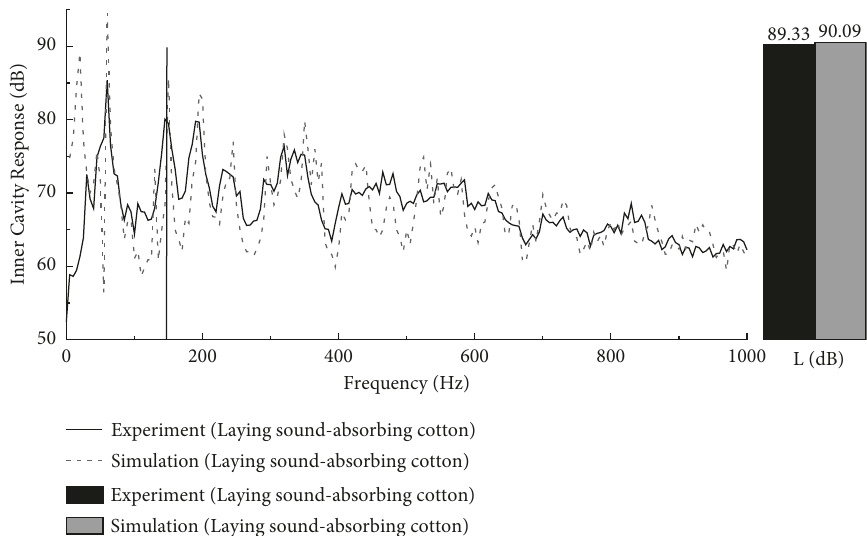
Figure 6: Comparison of internal response spectrum achieved from the experiment and simulation with the laying of sound-absorbing cotton.